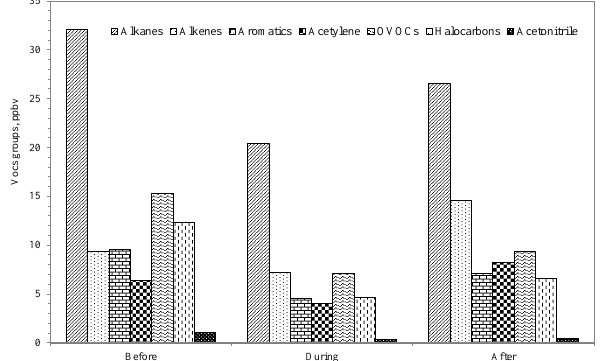
Figure 2. Mixing ratios of volatile organic compound (VOC) groups before, during, and after the control period during APEC China